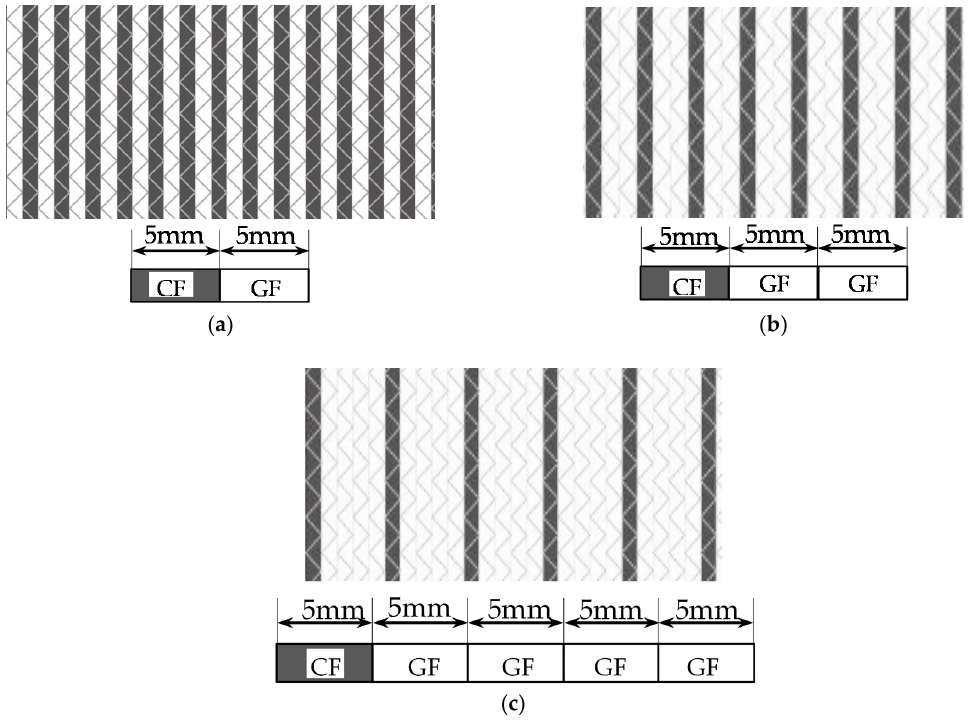
Figure 1. Schematic structures of three types of non-crimp fabrics (NCFs): ( a ) C – G; ( b ) C – G – G; ( c ) C – G – G – G – G.